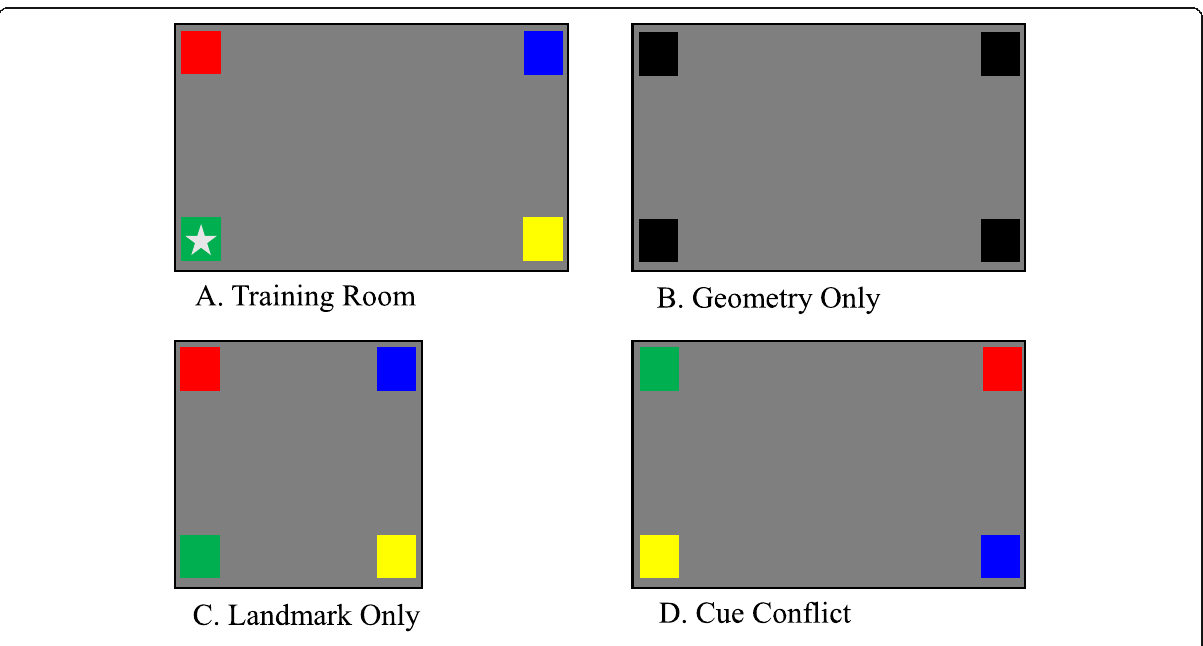
Fig. 2 Spatial reorientation room layouts. a Depicts the layout of the training room with the star indicating the goal location. b Depicts the Geometry Only test condition where there is no landmark information available for participants to utilize. c Depicts the Landmark (formerly Feature) Only test condition, where geometric information has been removed. d Depicts the Cue Conflict test condition, where the landmark information is rotated by one corner so that the landmark and geometric information are no longer corresponding to the training